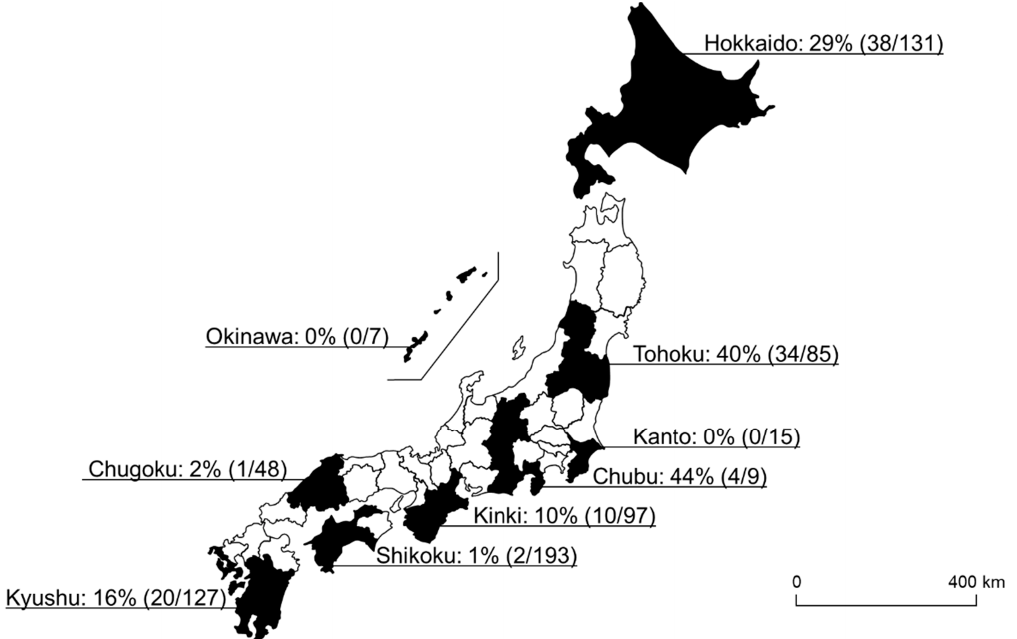
Figure 2. A map of Japan showing the Spiroplasma -positive rate of each geographical block. The numbers in the parentheses refer to the number of Spiroplasma -positive ticks/number of tested ticks.